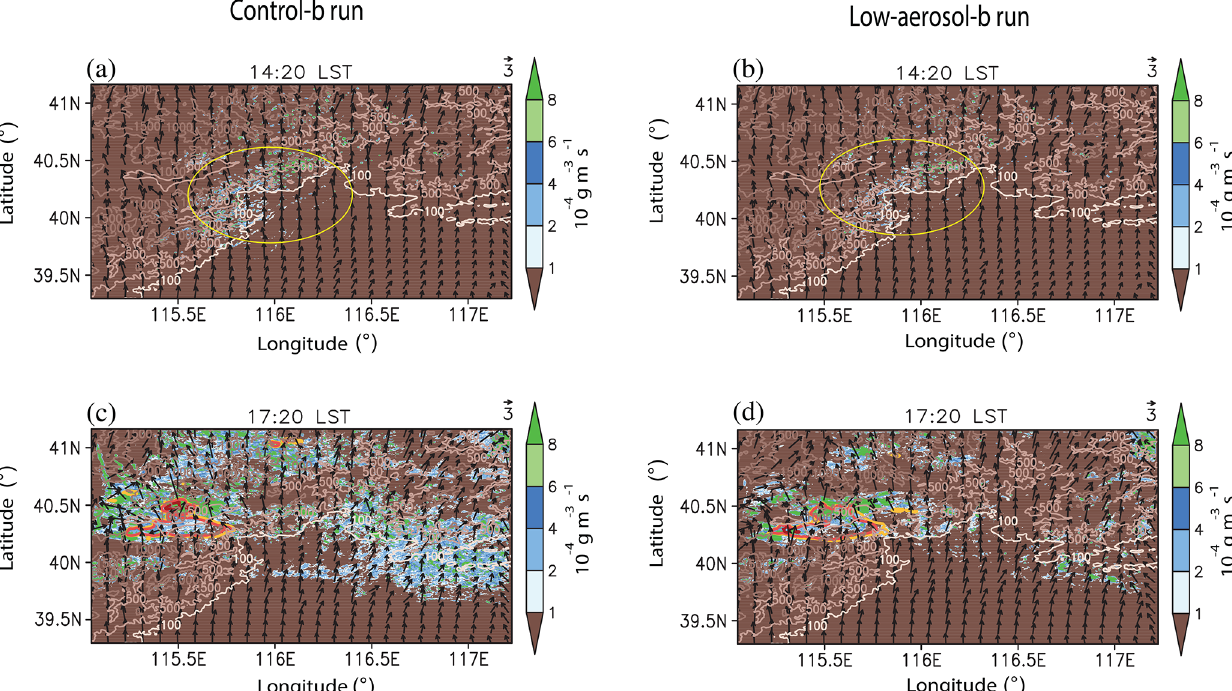
Figure 11. Spatial distributions of terrain heights, column-averaged condensation rates, surface wind vectors and precipitation rates at (a, b) 14:20LST, and (c, d) 17:20LST. (a, c) are for the control-b run and (b, d) are for the low-aerosol-b run. Condensation rates are shaded. Dark yellow and dark red contours represent precipitation rates at 1.0 and 2.0mmh − 1 , respectively, while beige, light brown, brown and dark brown contours represent terrain heights at 100, 500, 1000 and 1500m, respectively. See text for yellow circles in (a) and (b) .